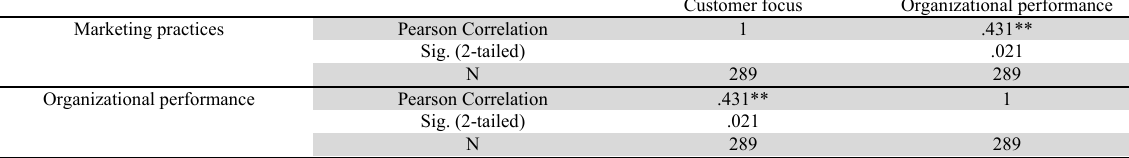
Correlation between marketing practices and organizational